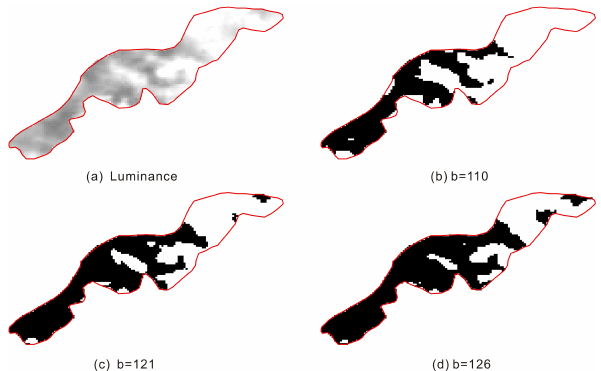
Figure 9. (a) Luminance of MODIS image with band 7–2–1; (b) flood extent extracted from the fixed digital number threshold 110; (c) flood extent extracted from the fixed digital number thresh- old 121; (d) flood extent extracted from the fixed digital number threshold 126.